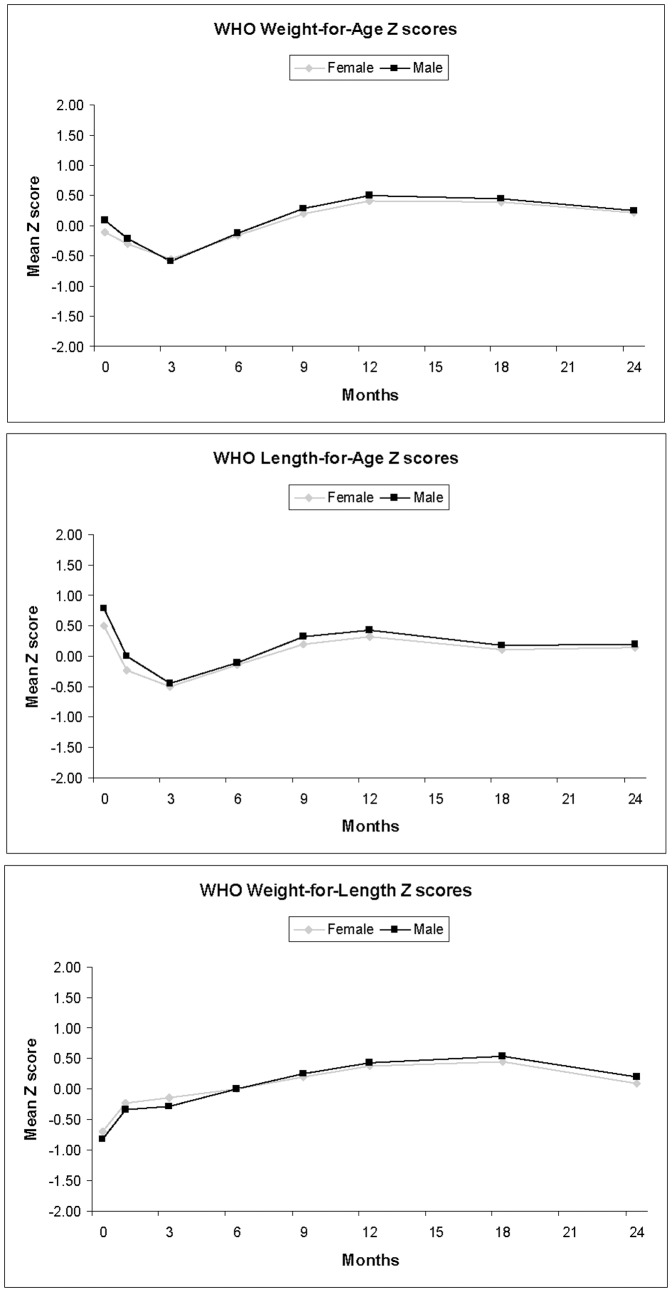
Mean WHO Infant Weight-for-Age, Length-for-Age, and Weight-For-Length Z scores by sex in the Fels Longitudinal study.